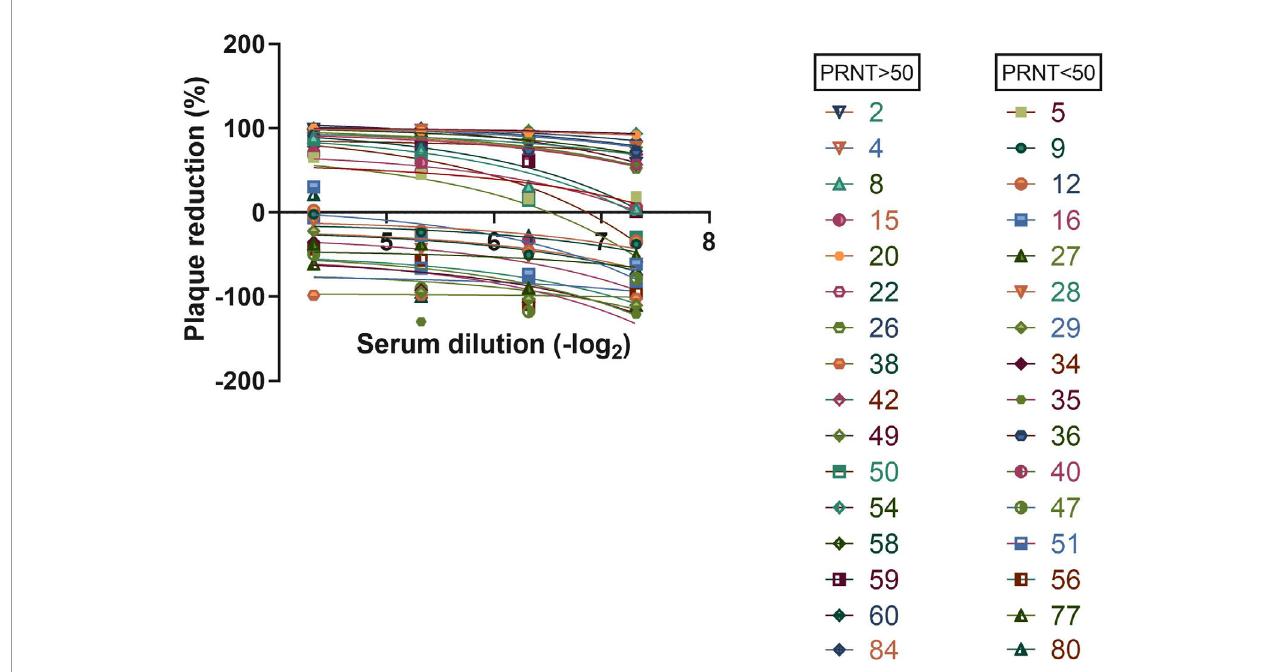
FIGURE 4 | Serum neutralization assay. Virus was incubated with indicated serum dilution following cell infection. Plaque reduction was